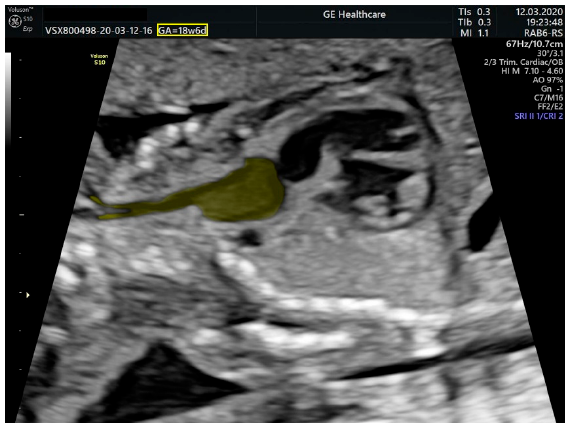
Figure 4. Sagittal section through the fetal cervical region and mediastinum. The aneurysm is located above the base of the heart and gives rise to a vascular structure that dichotomously branches in the cranial half of the cervical region.